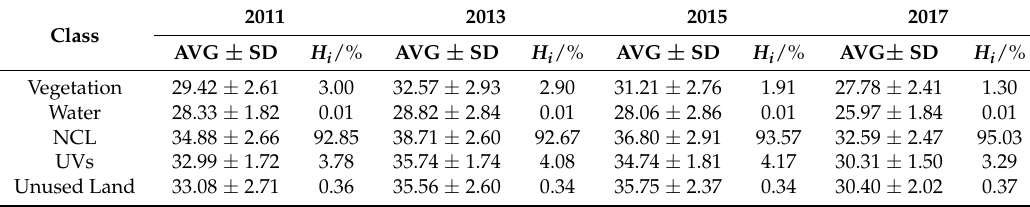
Table 5. Average surface temperatures and thermal effect contribution indices of thermal effect for different land-use types (AVG: average; SD: standard